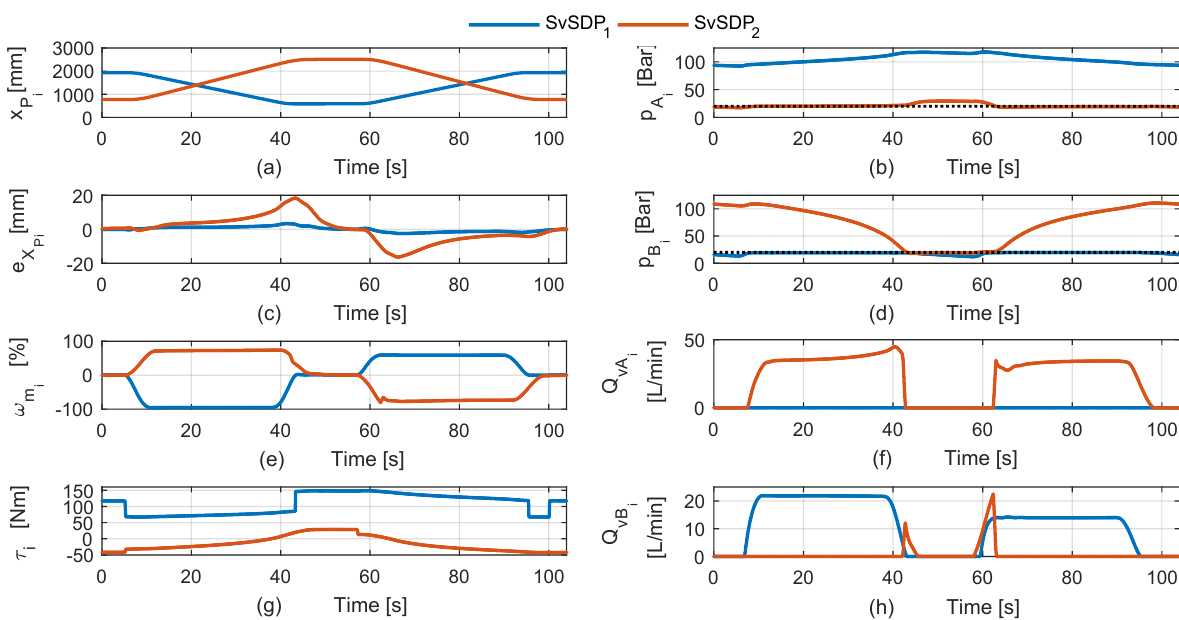
Figure 14: Performance results for SvSDP drives using the energy efficient input transformation in Eq 54. In (b) and (d) the dotted black line indicates the pressure setting, p set .